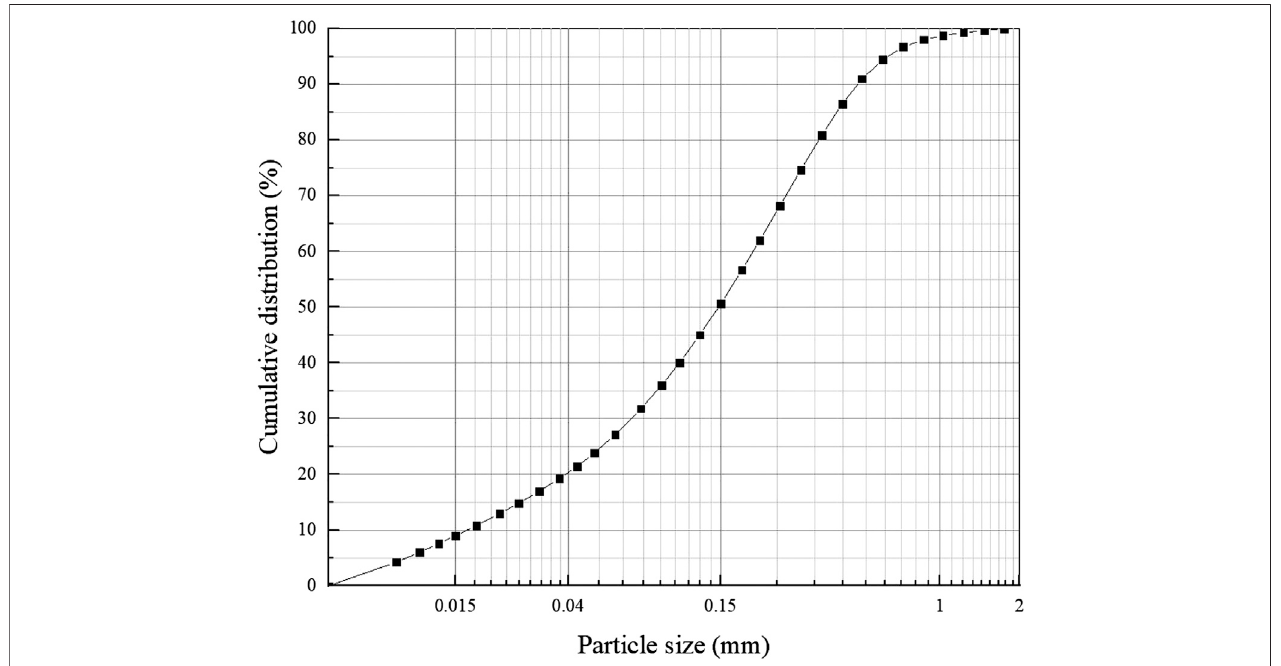
FIGURE 1 | Particle size distribution curves of soil.